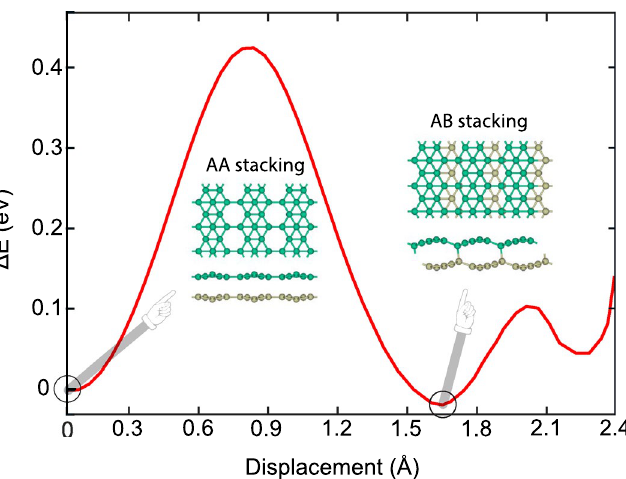
Figure 4. Variation of energy as a function of displacement along the armchair direction. The energy of AA stacking was set to zero. The AA and AB stackings are shown in the